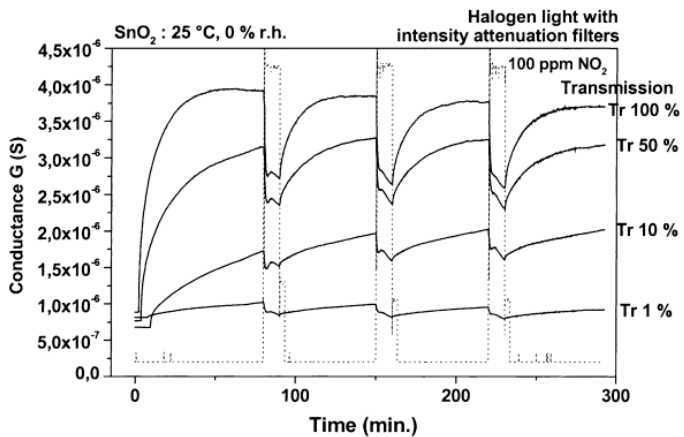
Figure 12. Gas response of SnO 2 towards 100 ppm NO 2 with and without illumination at 25 °C and 0% relative humidity. Conductance and contact potential difference (CPD) measurements are shown. Reproduced with permission from [50].